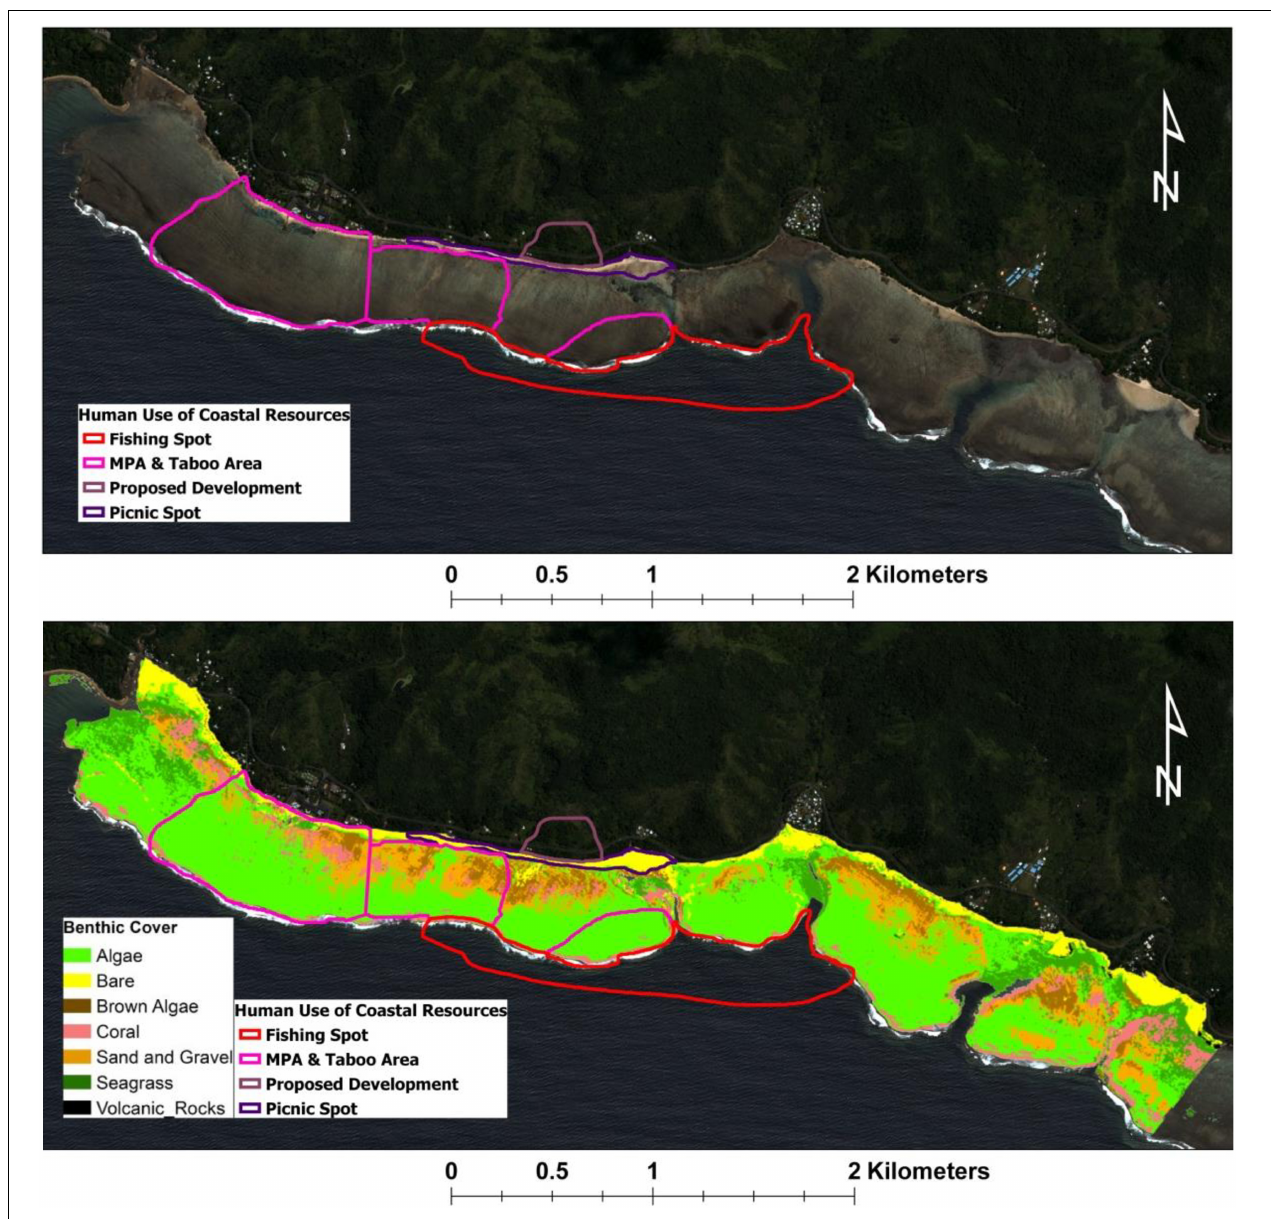
FIGURE 4 | Benthic cover map for Komave coastal habitats overlaid with human use activities; fishing sites, proposed developments, picnic spot and marine protected area (MPA)/taboo area. (Top) Without benthic cover classes; (Bottom) with benthic cover